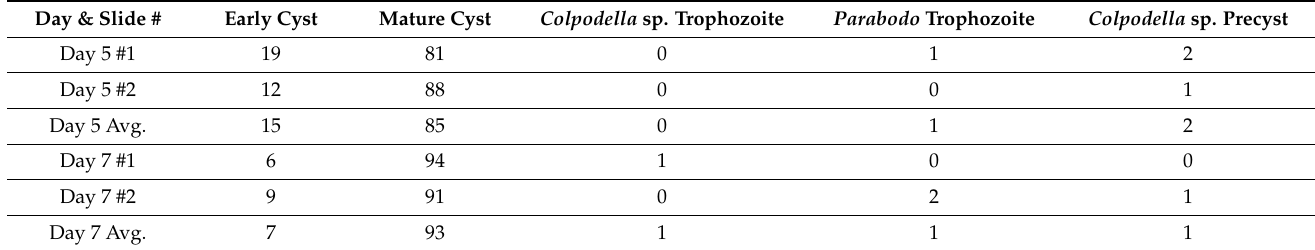
Table 1. Resting cysts of Colpodella sp. (ATCC 50594) and trophozoites on days 5 and